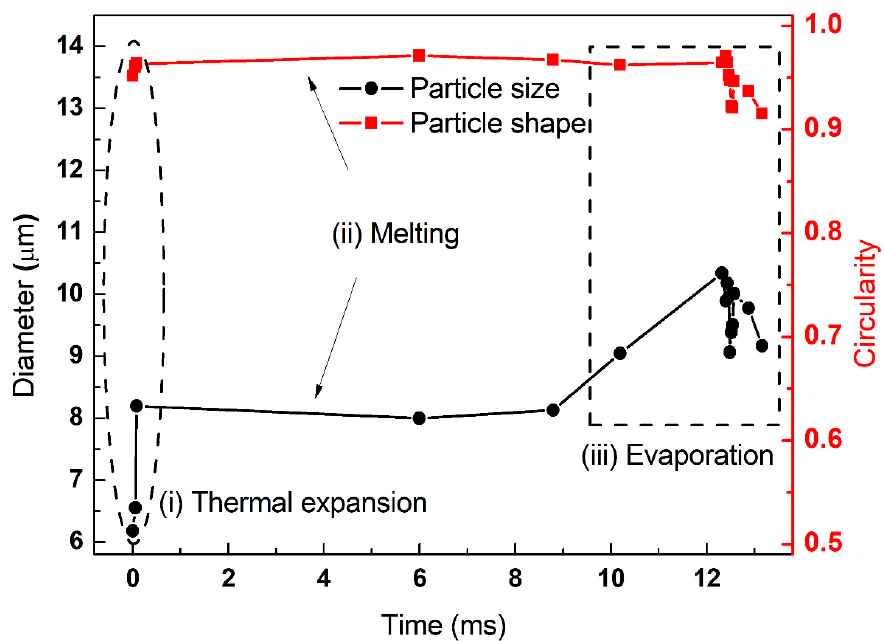
Figure 9. The variation of particle diameter and circularity of individual aluminum particles (initial diameter of 6.25 µ m, laser power density of 8.81 × 10 5 W / cm 2